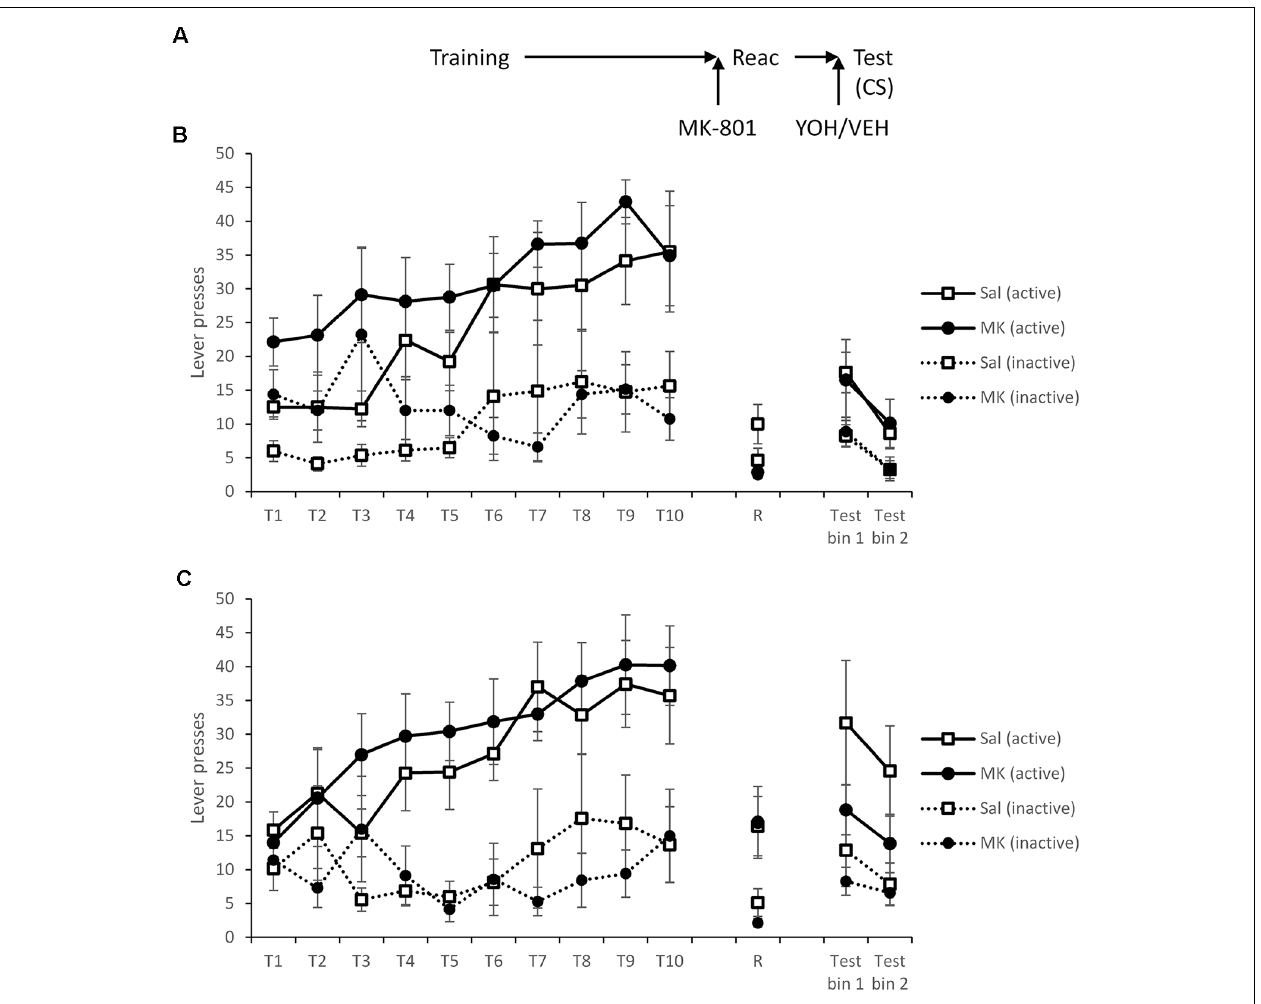
FIGURE 4 | Administration of yohimbine did elevate instrumental responding in the presence of the CS, but not obviously in MK-801-treated rats. (A) Schematic of the experiment. (B) Rats receiving vehicle prior to test. (C) Rats receiving yohimbine prior to test. Rats learned to lever press for cocaine over training days 1–10 (T1–T10). At reactivation (R), there was no acute effect of MK-801 on performance, but the groups did differ depending on whether they subsequently received yohimbine. Thirty minutes prior to testing rats were injected with yohimbine or vehicle and were tested with active lever presses reinforced by the CS. Yohimbine elevated test responding, more obviously in saline-treated rats. CS presentation recovered responding in the absence of yohimbine, but less obviously so with pre-test yohimbine. Data are presented as summary mean ± SEM (yohimbine groups: n = 7; vehicle groups: n =